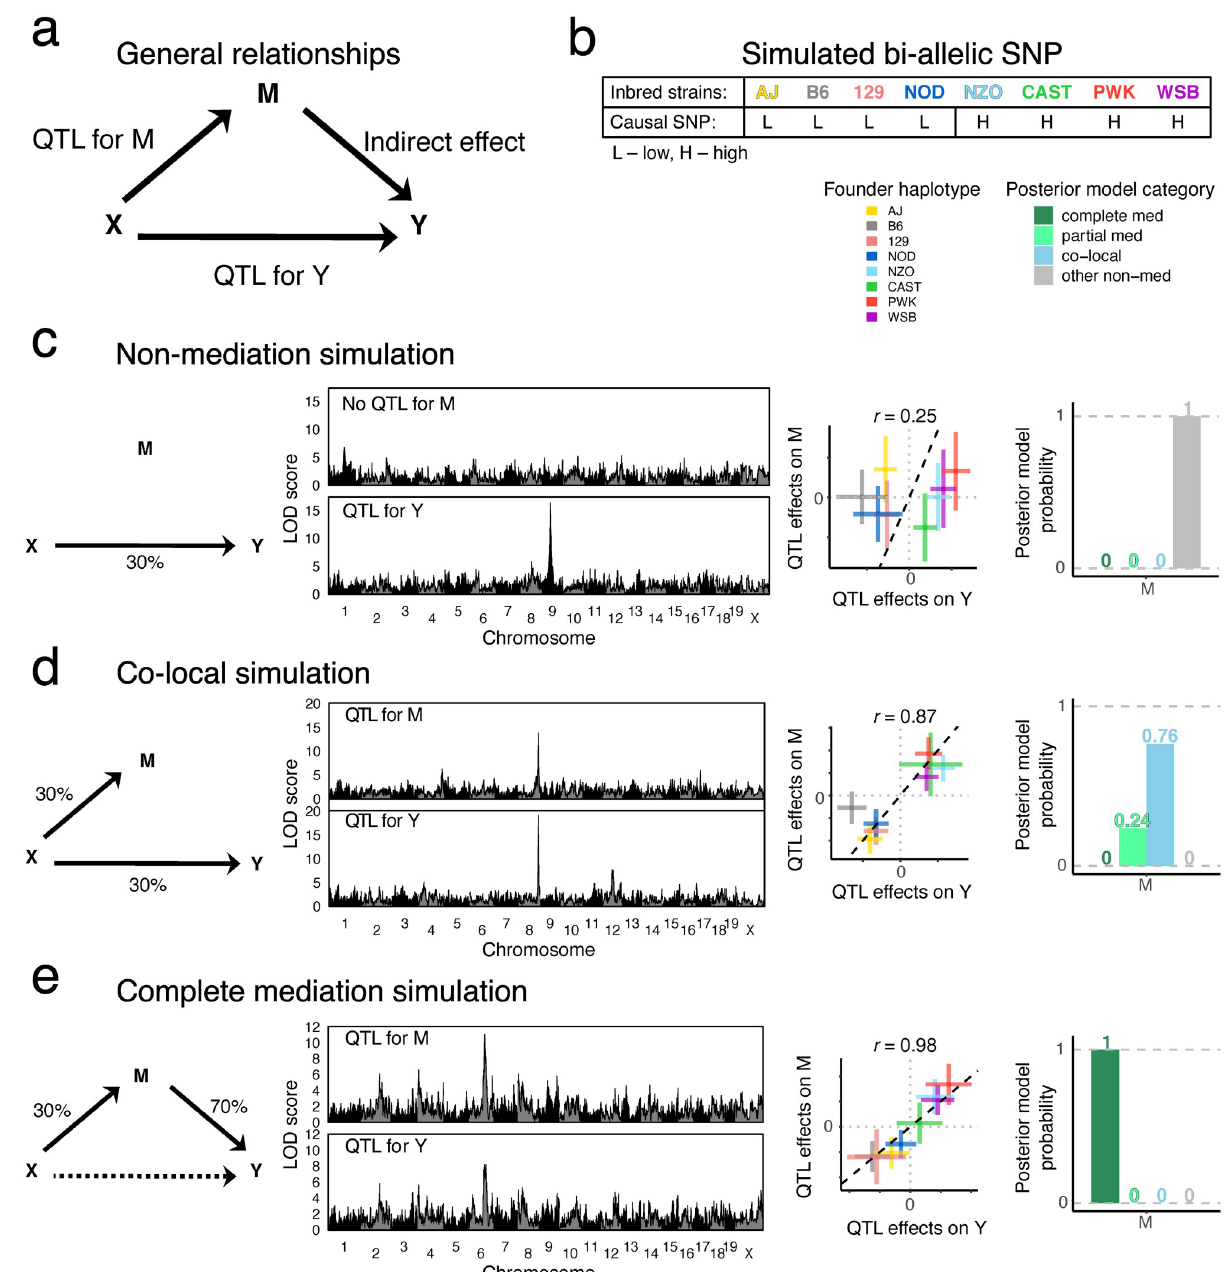
Fig 5. Illustration of Bayesian model selection applied to QTL mapping with simulated DO mouse data. (a) The DAG is labeled to indicate how each arm in the mediation model is interpreted in the QTL mapping setting. Y and M were simulated based on a bi-allelic QTL X at a randomly selected locus, with (b) each allele distributed to four founder strains. Genome-wide genotype data were obtained from 192 DO mice, according to one of three models: (c) M is a non-mediator of X on Y, (d) M and Y are independently driven by X (co-local), and (e) M is a complete mediator of X on Y, as illustrated with the corresponding model DAG with the simulated effect sizes indicated in units of percent variance explained (left). Genome-wide LOD scores for QTL mapping of M and Y, a scatter plot of the founder haplotype effects at the QTL for M and Y, and the Bayesian model selection posterior model probabilities are shown (from left to